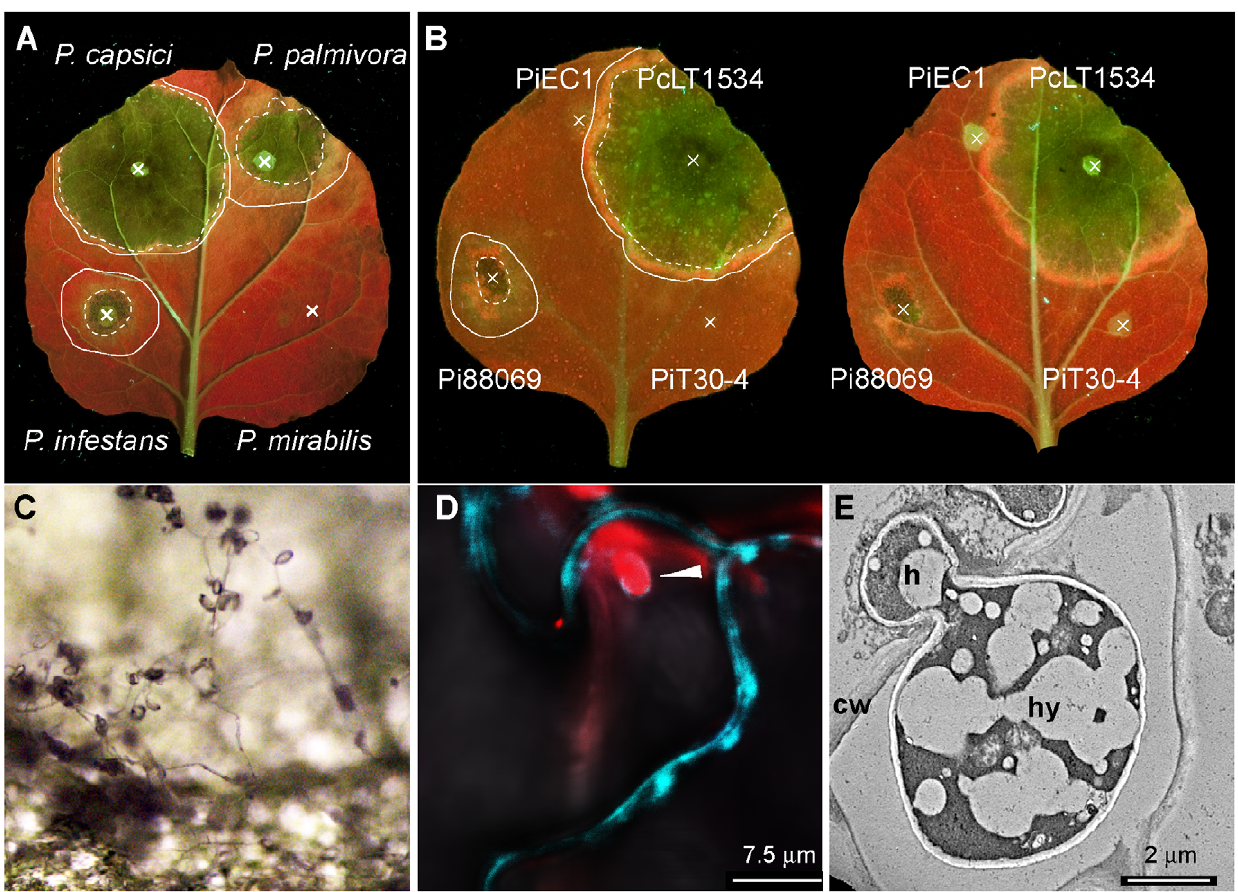
Figure 1. N.benthamiana shows varying degrees of susceptibility to Phytophthora species and P.infestans isolates. Detached leaves of N. benthamiana were infected with spore solution droplets (marked as X) of Phytophthora capsici LT1534, P. palmivora 16830, P. infestans 88069 and P. mirabilis PIC99114. (A) or P. infestans isolates (B) and using P. capsici as a reference. Photographs were taken 3 days post inoculation under UV illumination. Lines mark infected areas, dotted lines mark the border between necrotic tissue and biotrophic tissue. P. infestans is able to produce sporangia on N. benthamiana 8 days post infection (C ). P. infestans isolate 88069td (expressing tdTomato red fluorescent protein) formed digit like haustoria (arrowhead) that invaginated the N. benthamiana cell membrane labelled by transient Agrobacterium tumefaciens mediated expression of